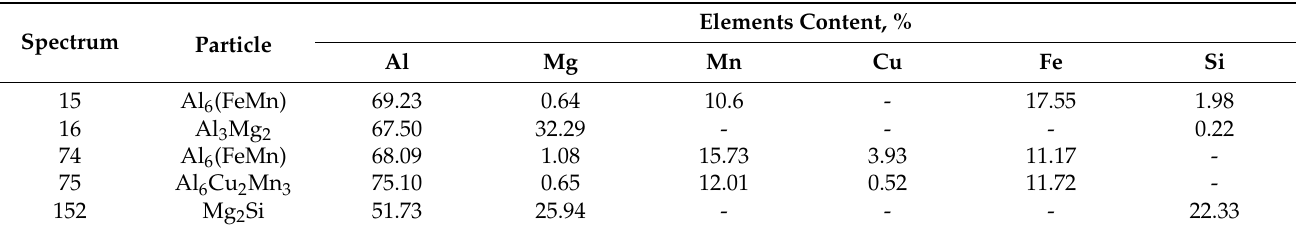
Figure 8. Change of dispersoid size and number depending on alloy chemical composition. Table 3. Content of elements in particles.